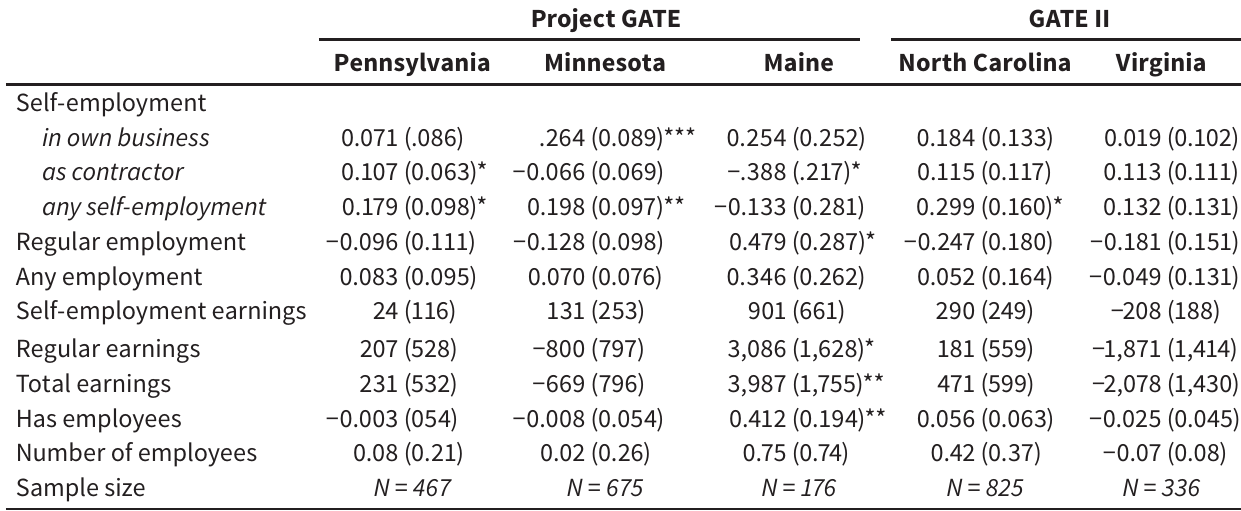
Local average treatment effects on labor market outcomes